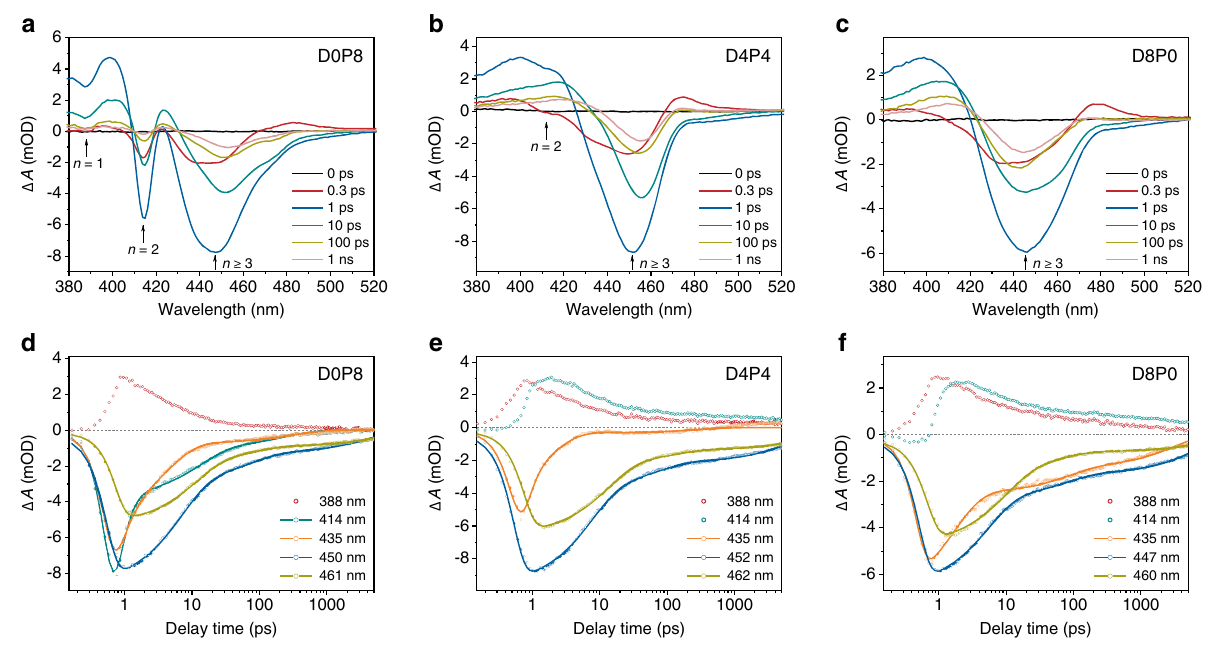
Fig. 3 TA characterizations of the CsPbClBr 2 nanocrystal fi lms. a – c TA spectra at different delay times for the samples of a D0P8, b D4P4, and c D8P0, respectively. d – f TA kinetics of n = 1, 2, 3, 4 and n ≥ 5 domains for the samples of d D0P8, e D4P4, and f D8P0, respectively. Solid lines are the fi tting curves using exponential